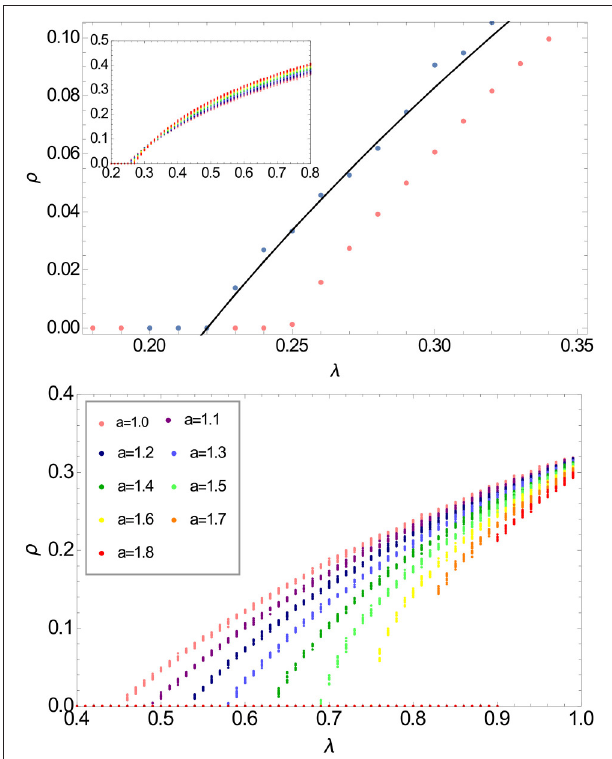
FIGURE 3 | Simulations of the microscopic model on a degree regular random network with degree k = 10. Individuals might adopt with probability P ( n ). Upper panel shows the results for T = 1.2 and lower panel for T = 3 for different values of a . For T = 1.2 the transitions are continuous for any a (inset, same color code as lower panel). The upper panel shows the region of the critical point for the simulations of the microscopic model on the quenched network (pink), the simulations on the annealed network (blue) and the exact solution (black line) of the equation for a = 1.0, respectively. For T = 3 there are continuous or discontinuous transitions depending on the value of a